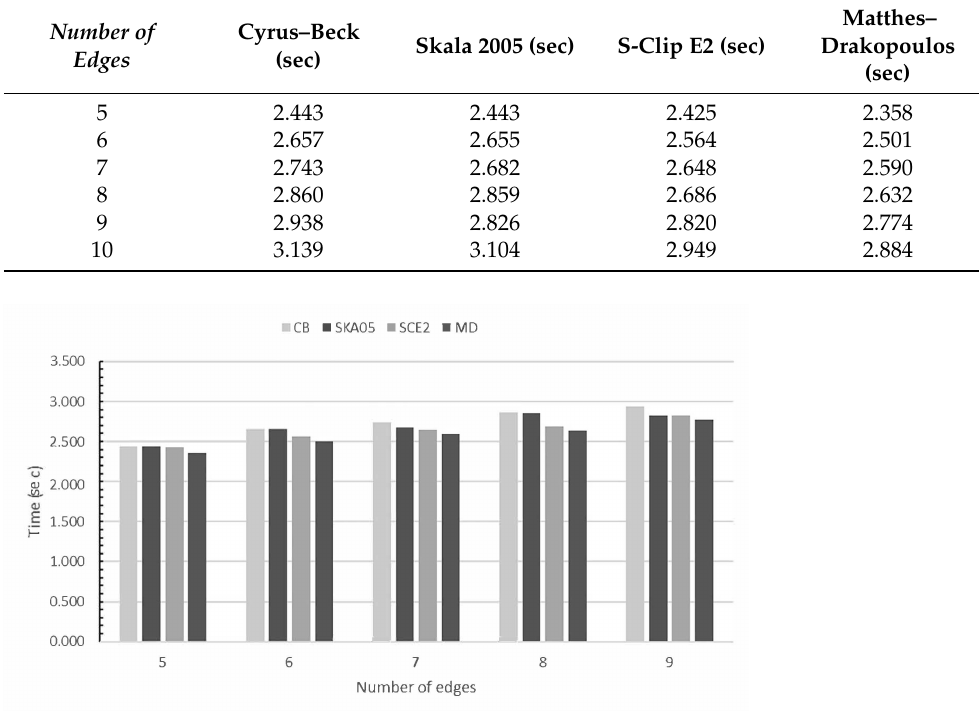
Table 4. Average execution time of each algorithm when clipping 10 million lines against convex polygons with different numbers of edges.